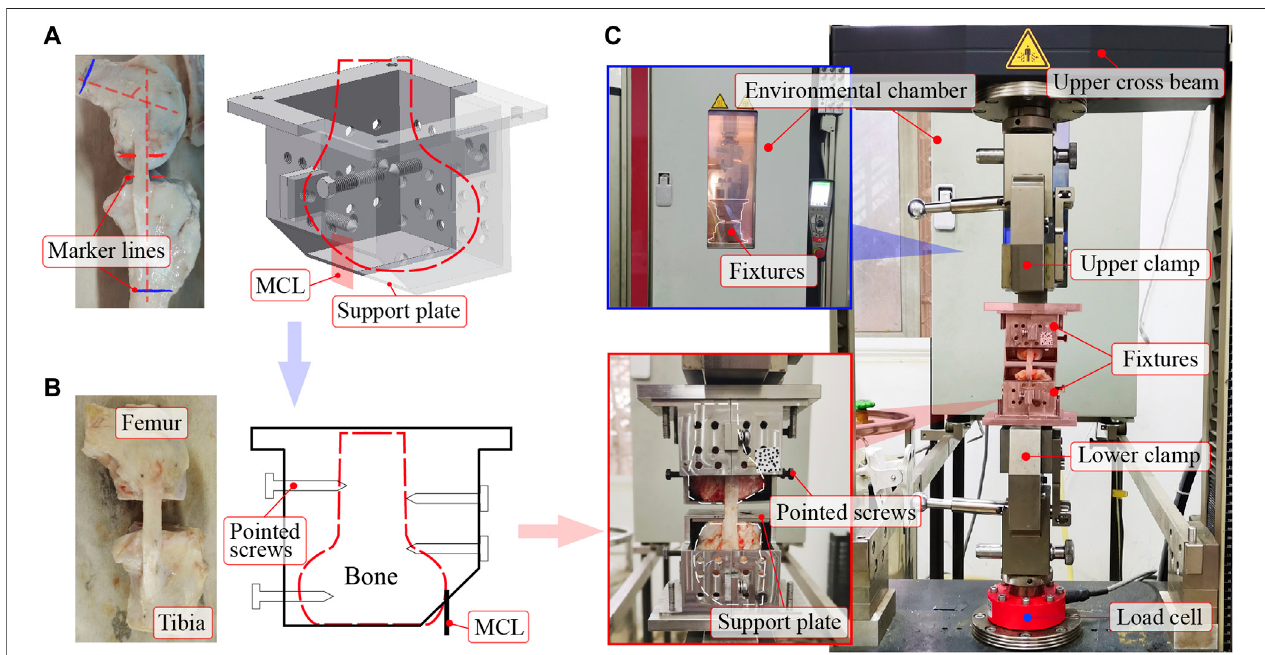
FIGURE 1 | The femur-MCL-tibia complex mounted on a tensile apparatus. (A) Intact femur-MCL-tibia complex, and its condyle placed in a custom-made fi xture (beforesawing).Theredparallelmarkerlinesindicatethecontactsurfacesbetweenthecondylesandsupportplates.Thebluemarkerlinesmarkthemaximumallowable bone length that the fi xtures can entirely wrap. (B) Osteotomized femur-MCL-tibia complex, and its condyle fi xed in the fi xture by pointed screws (after sawing). The pointedscrewswerescrewedintothecondylethroughthreadholesonthesidewallsofthe fi xture. (C) The fi xtureswereclampedbytheupperandlowerclampsof thetestingmachineafter fi xingthefemur-MCL-tibiacomplexinthe fi xtures.Anenvironmentalchamberwasusedtocontroltheexperimentaltemperature.MCL=medial collateral